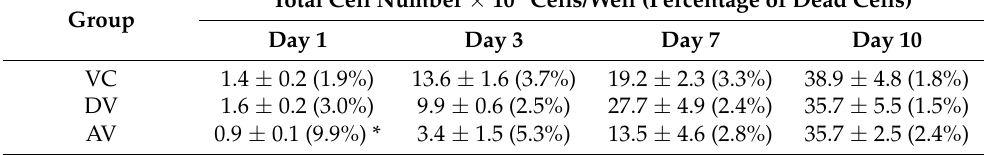
Figure 2. Proliferation of J774A cells after ingesting OJ-1 and cell area. ( A ) Time courses of the proliferation activity of J774A cells incubated in 10% FBS containing DMEM with VCM without using OJ-1 (VC group) and with ethanol pretreated dead OJ-1 (DV group) and living OJ-1 (AV group). Data: mean ± S.D. *: p < 0.05 vs. VC group. ( B ) The doubling times in the VC, DV, and AV groups are shown using their initial exponential growths. ( C ) The cell size was measured during 10 days of incubation. Data are shown in a box-and-whisker plot. Note, data deviation is more pronounced on day 0 in the DV group but on day 3 in the AV group. Table 1. Total J774A cell number in culture after ingesting dead OJ-1 (DV) and living OJ-1 (AV) in the presence of vancomycin.